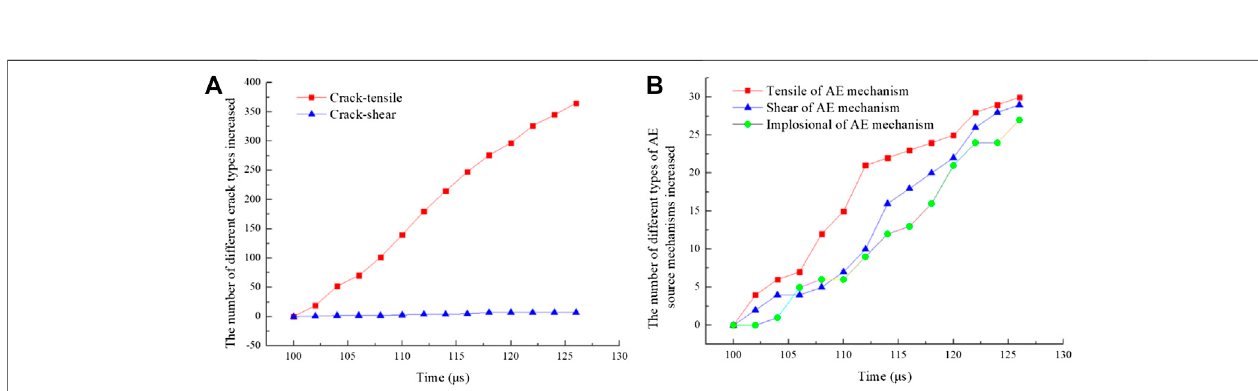
FIGURE 11 | The new increased micro-crack from 100 to 126 µs. (A) is the number of different crack types increased from 100 to 126 µs. (B) is the number of different types of AE source mechanisms increased from 100 to 126 µs.